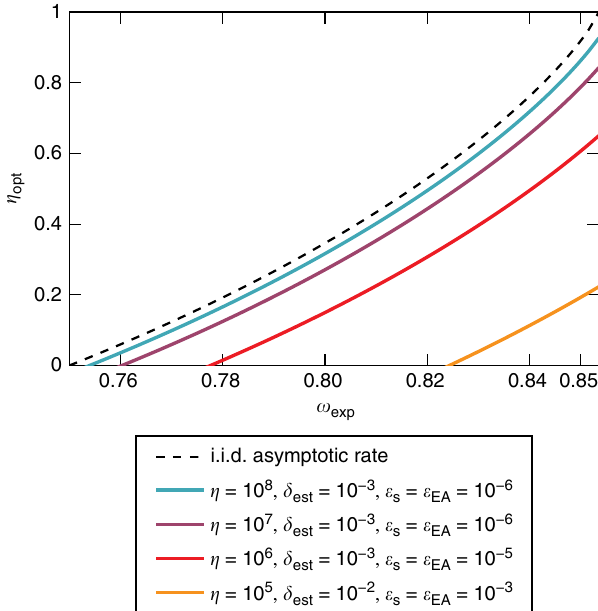
Fig. 7 Entropy rate for entropy accumulation protocol. η opt ( ω exp ) for γ = 1, s = 1 and several choices of δ n , ε ε max est , EA , and s . We optimise the rates over all parameters which are not explicitly stated in the fi gure. The dashed line shows the optimal asymptotic ( n → ∞ ) rate under the assumption that the devices are such that Alice, Bob, and Eve share an (unknown) i.i.d. state and n →